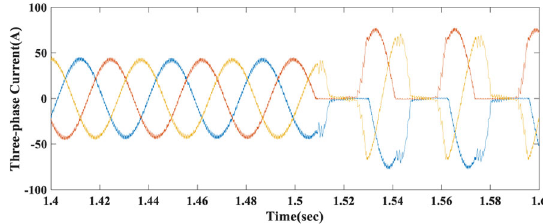
Fig. 3 The waveform when T 4 is under open-circuit fault